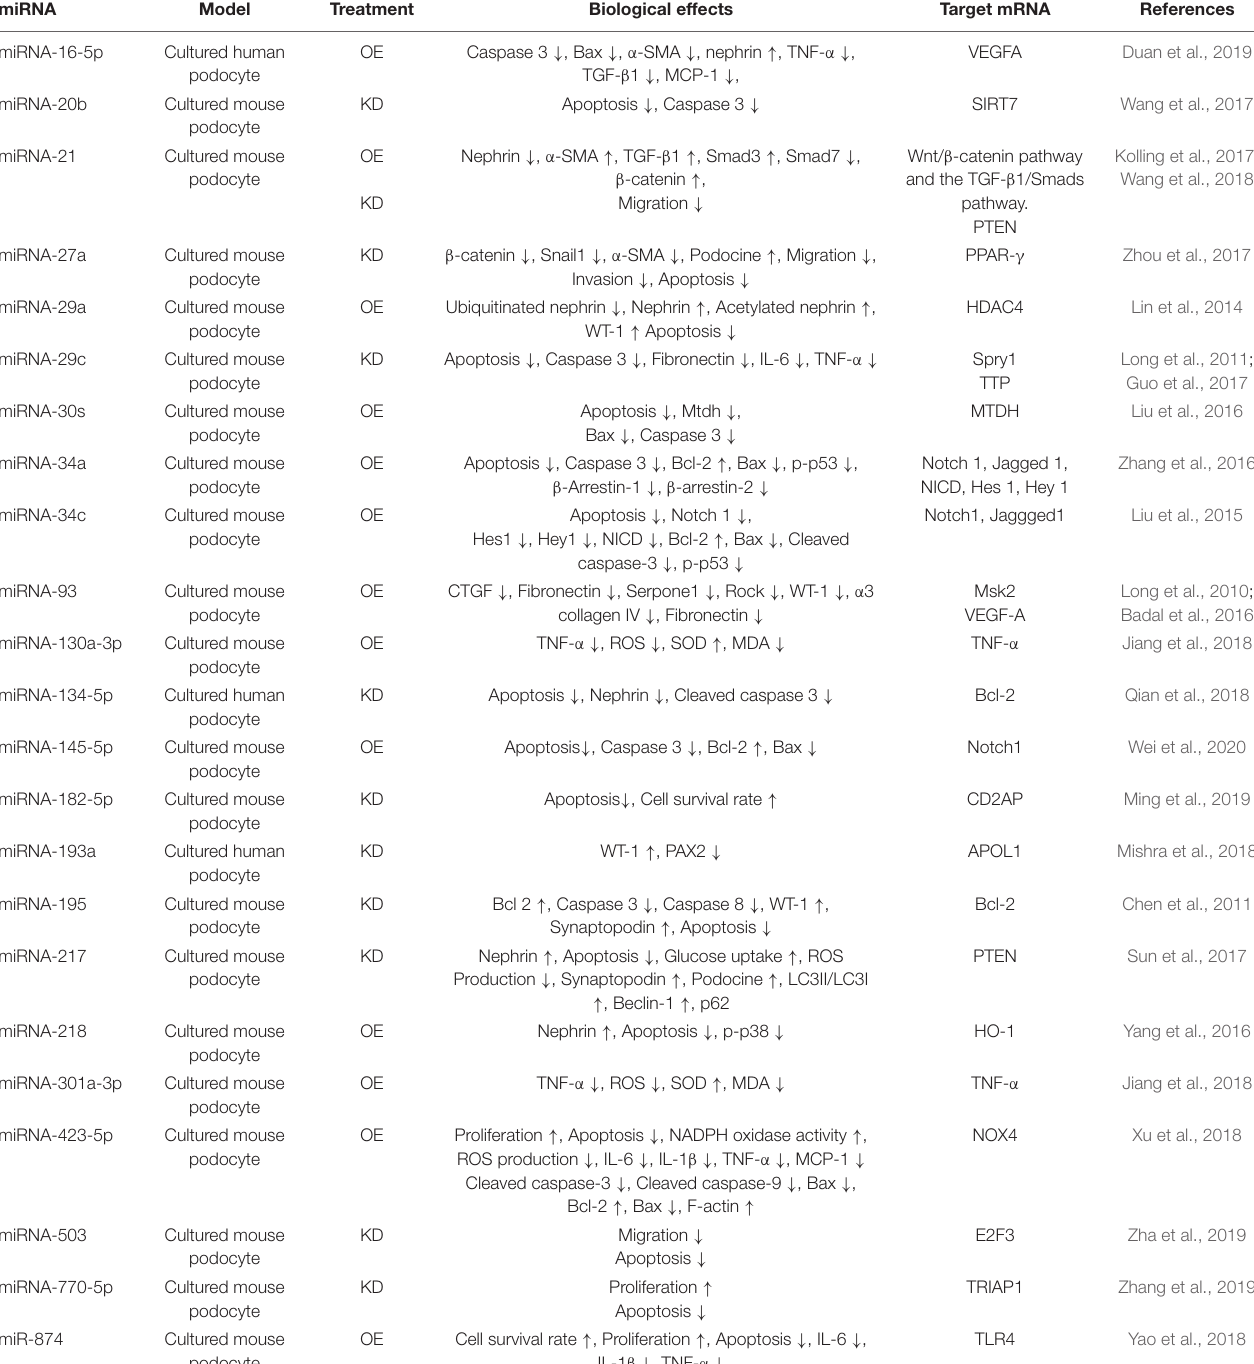
TABLE 3a | Effects of changes of miRNA expression levels on podocyte injury in diabetic nephropathy in vitro. miRNA